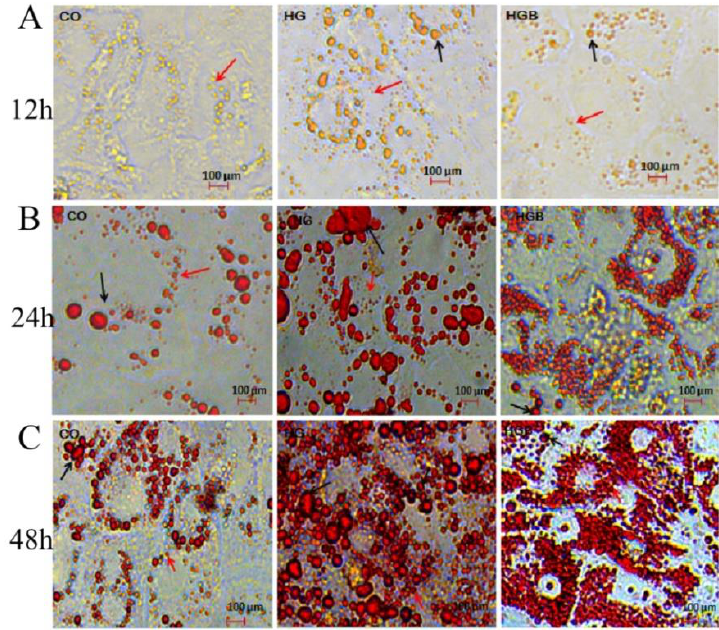
Figure 4. Oil red-O staining of Landes goose primary hepatocytes at different times and different treatments. Landes goose primary hepatocytes were starved in serum-free medium for 24 h and then cultured for different times (( A ):12 h, ( B ):24 h, ( C ):48 h) with high glucose or high glucose and betaine. CO: control group (0 mmol/L of glucose + 0 mmol/L of betaine); HG: 20 mmol/L of glucose + 0 mmol/L of betaine group; HGB: 20 mmol/L of glucose + 20 mmol/L of betaine combined treatment group; red arrow: little droplets; black arrows: big droplets.